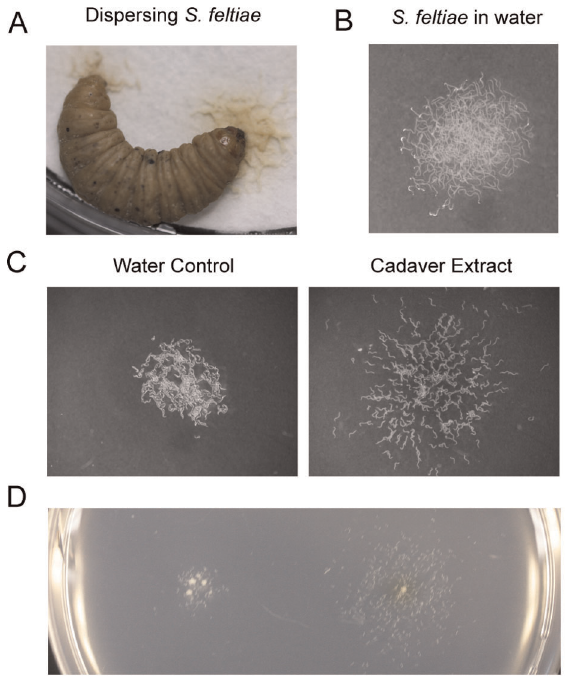
Figure 1. Dispersal assay. (A) Naturally dispersing infective juveniles (IJ) of S. feltiae from an insect cadaver. (B) Approximately 300 IJs were placed on an agar plate in water. (C) IJs were treated with either water (control) or insect cadaver extract. Images are representative of six experiments for each treatment. (D) Dispersal assay on the same plate. The illustration represents two experiments. Behavior is temperature and season dependent. Assays were conducted at RT (22 6 0.5 u C) or under temperature controlled conditions.